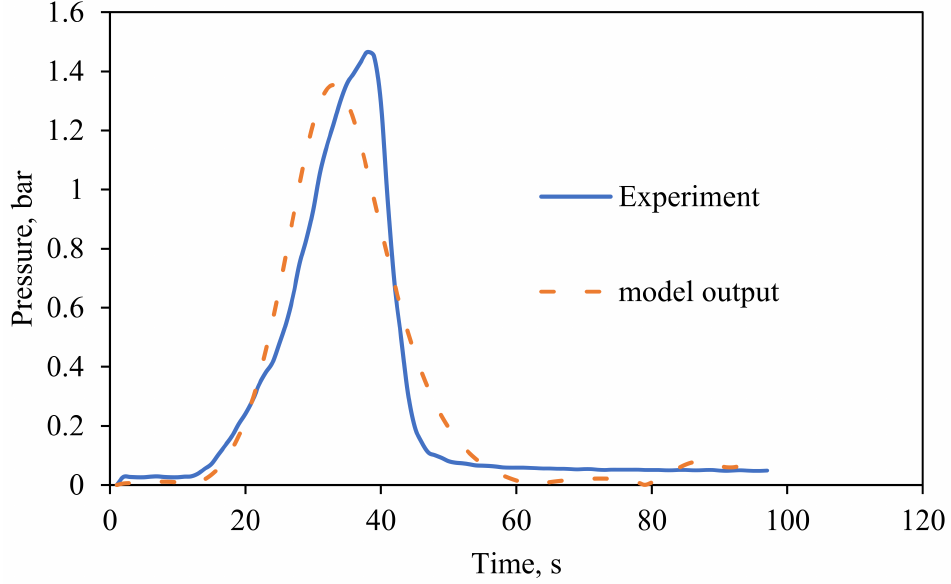
Figure 13. Comparison of the ANN model output and observation for the instantaneous gas injection